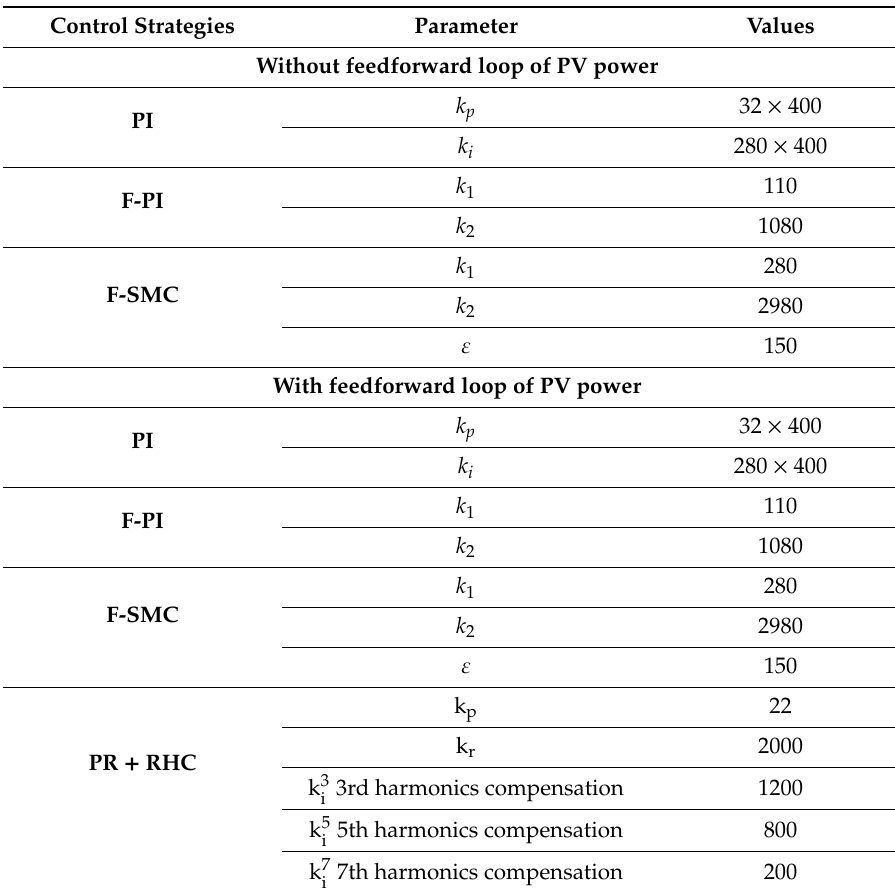
Table A2. Control Schemes